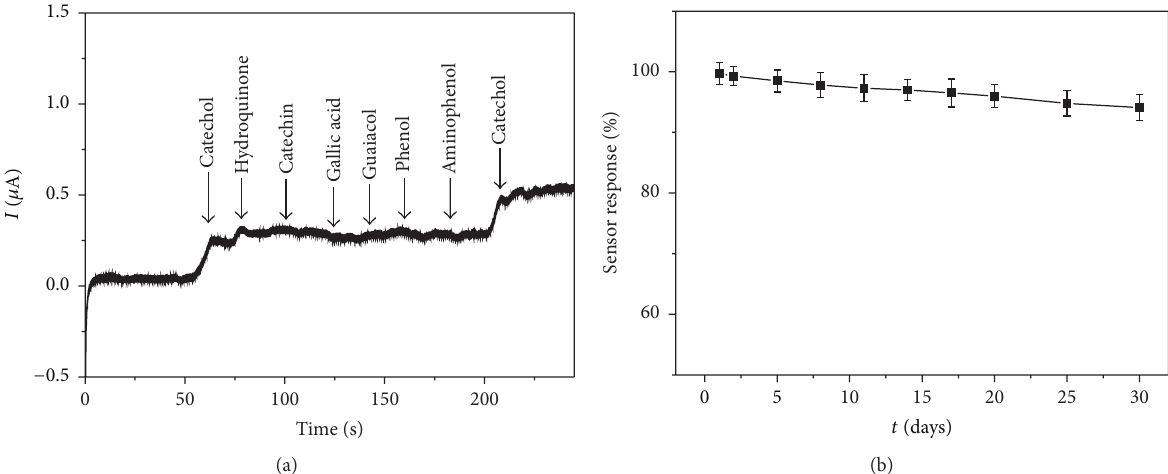
Figure 8: (a) Amperometric responses of PDA-Lac-rGO-Pb/GCE after the addition of different interfering substances; (b) long-term storage stability of PDA-Lac-rGO-Pb/GCE in 0.1M acetate buffer solution (pH 5.0) at 4 ∘ C.